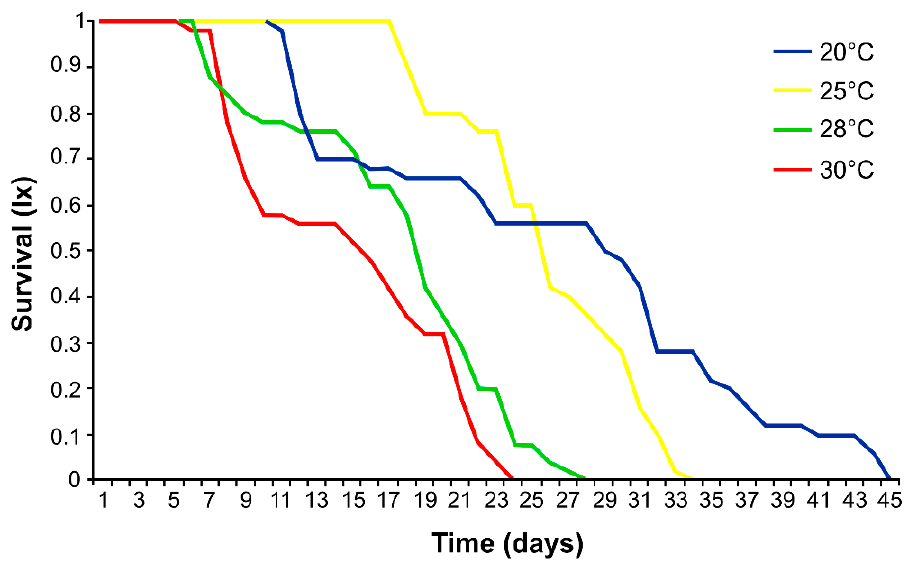
Figure 1. Effect on survival rates of apterous Phorodon cannabis ( n = 50 individuals at each temperature: 20, 25, 28, 30 °C).